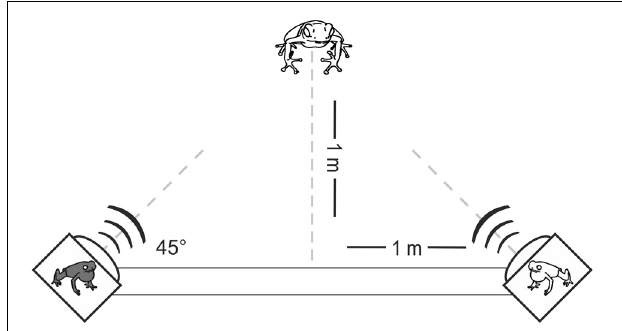
FIGURE 2 | Experimental setup for two-choice playback experiments. Model frogs positioned on top of the loudspeakers were only present in bimodal experiments (experiments III–V; Figure 3 ).